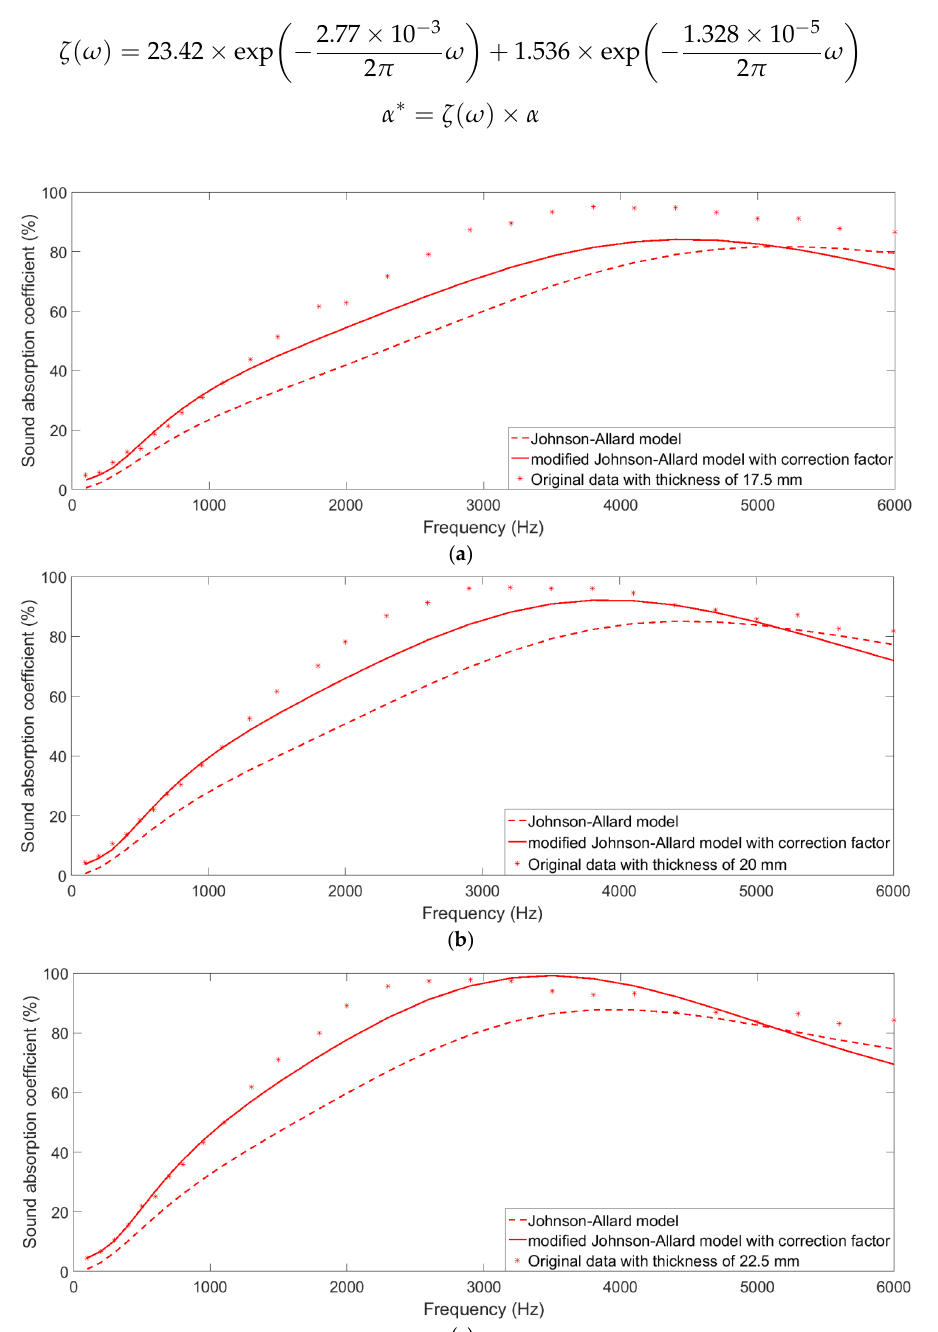
Figure 6. Comparisons of the predicted sound absorption coefficients of the compressed porous Ni – Fe sample by the Johnson – Allard model and those by the modified Johnson – Allard model with a correction factor. ( a ) Sample with thickness of 17.5 mm; ( b ) Sample with thickness of 20 mm; ( c ) Sample with thickness of 22.5 mm.